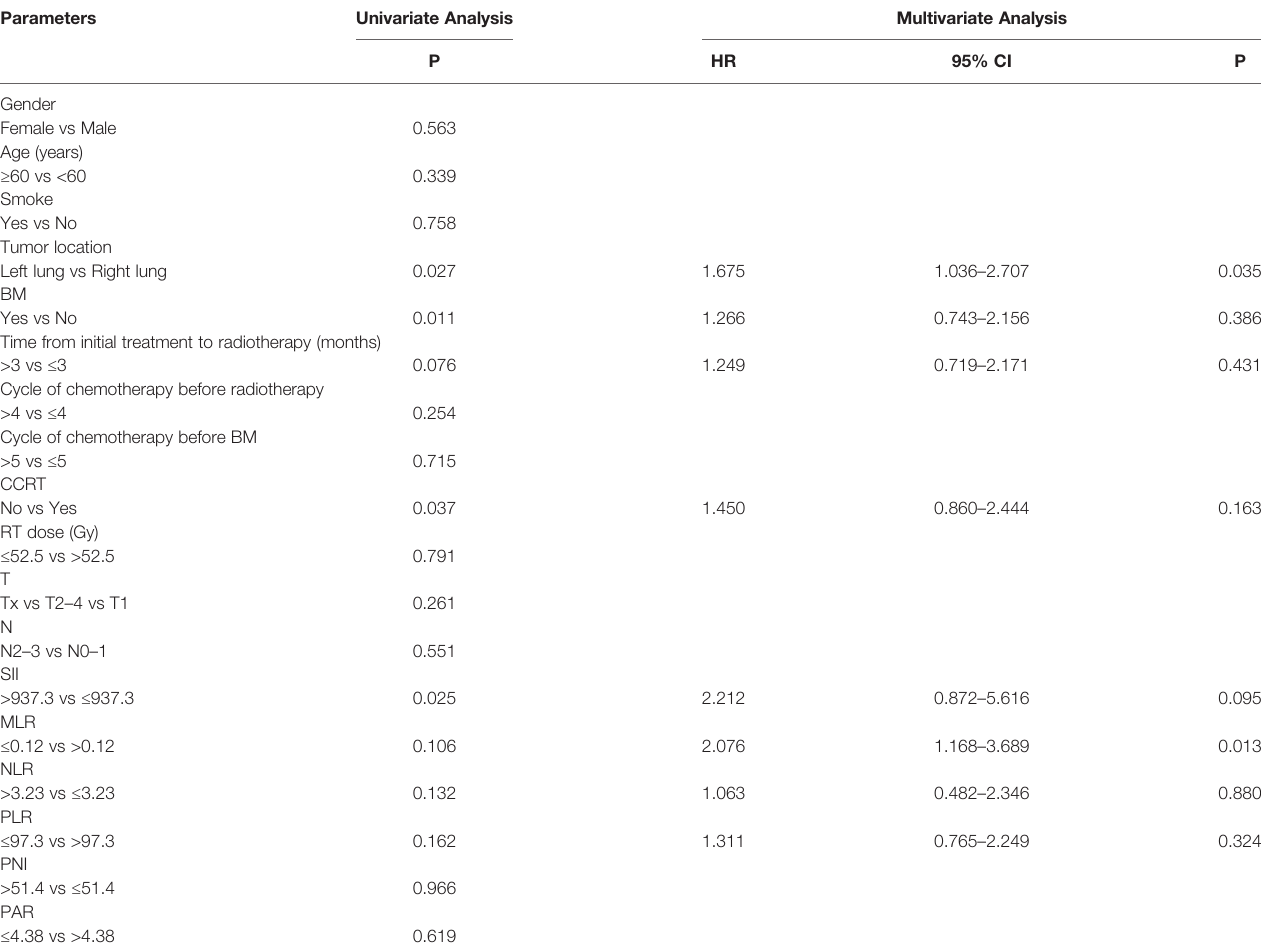
TABLE 3 | Log-rank tests and Cox regression analysis of factors associated with OS.